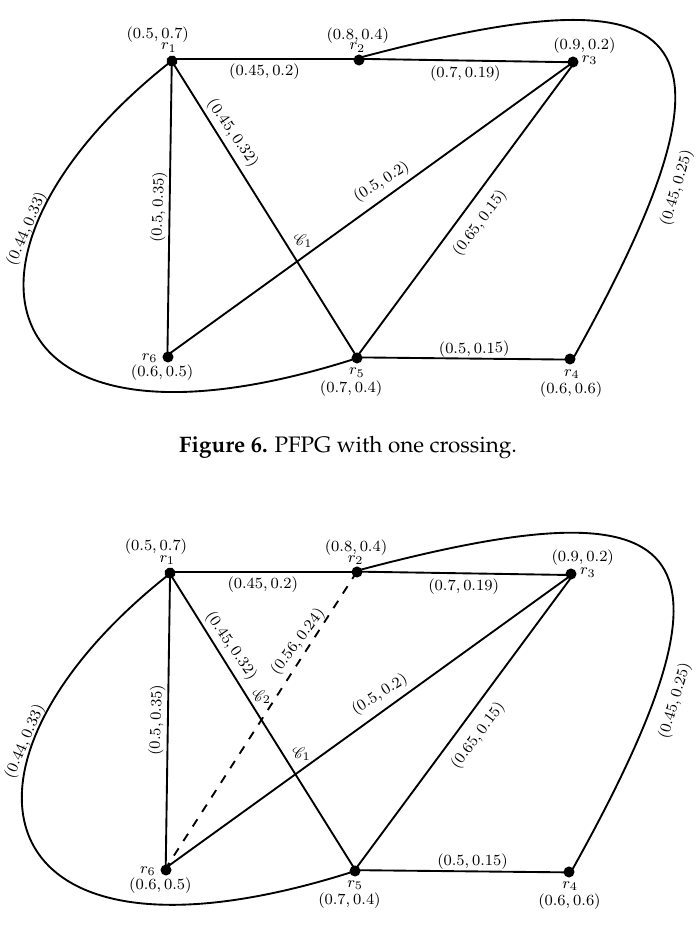
Figure 3.4: PFPG with two crossing A Pythagorean fuzzy planar graph G 1 and G 2 with one and two crossing between strong edges 239 ( r 1 r 5 , 0 . 45 , 0 . 32) , ( r 3 r 6 , 0 . 5 , 0 . 2) and ( r 1 r 5 , 0 . 45 , 0 . 32) , ( r 2 r 6 , 0 . 56 , 0 . 24) have Pythagorean fuzzy pla- 240 narity value F 1 = (0 . 53 , 0 . 70) and F 2 = (0 . 36 , 0 . 53) that satisfies F M 1 ≤ 0 . 67, F N 1 ≥ 0 . 67 and 241 F M 2 ≤ 0 . 5, F N 2 ≥ 0 . 5 , respectively. Moreover, it is easy to see that between strong edges if there is 242 no intersection, then PF planarity value F M > 0 . 67 and F N < 0 . 74 . Hence, this analysis and above 243 two example justify the statement of Theorem ?? . 244